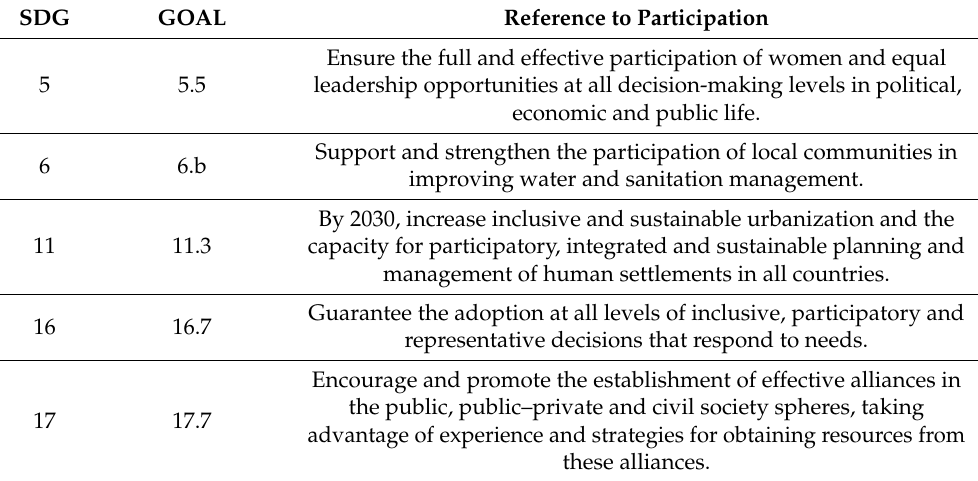
Table 1. SDG goals with references to